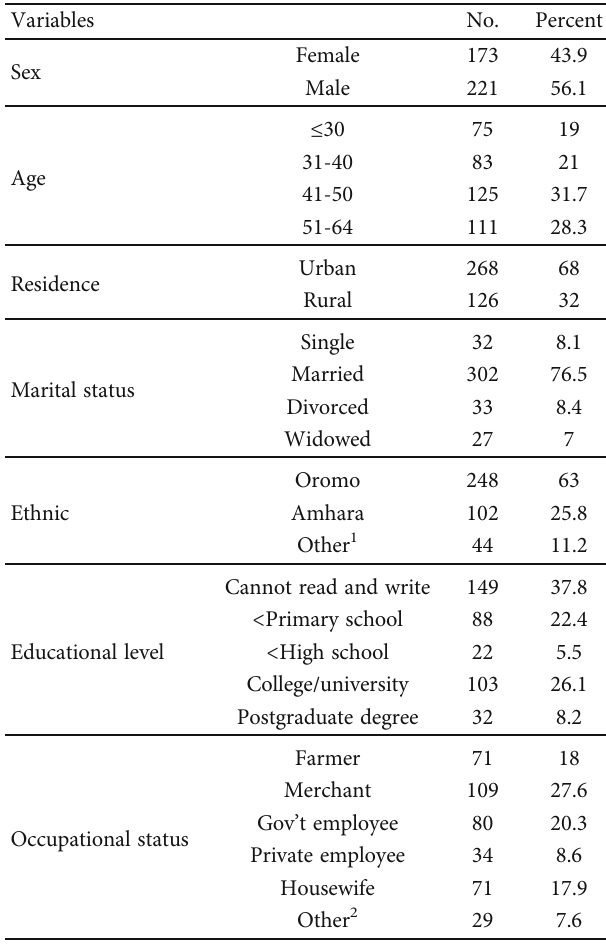
Table 1: Sociodemographic characteristics of type 2 diabetic patients at hospitals in Southwest Ethiopia,